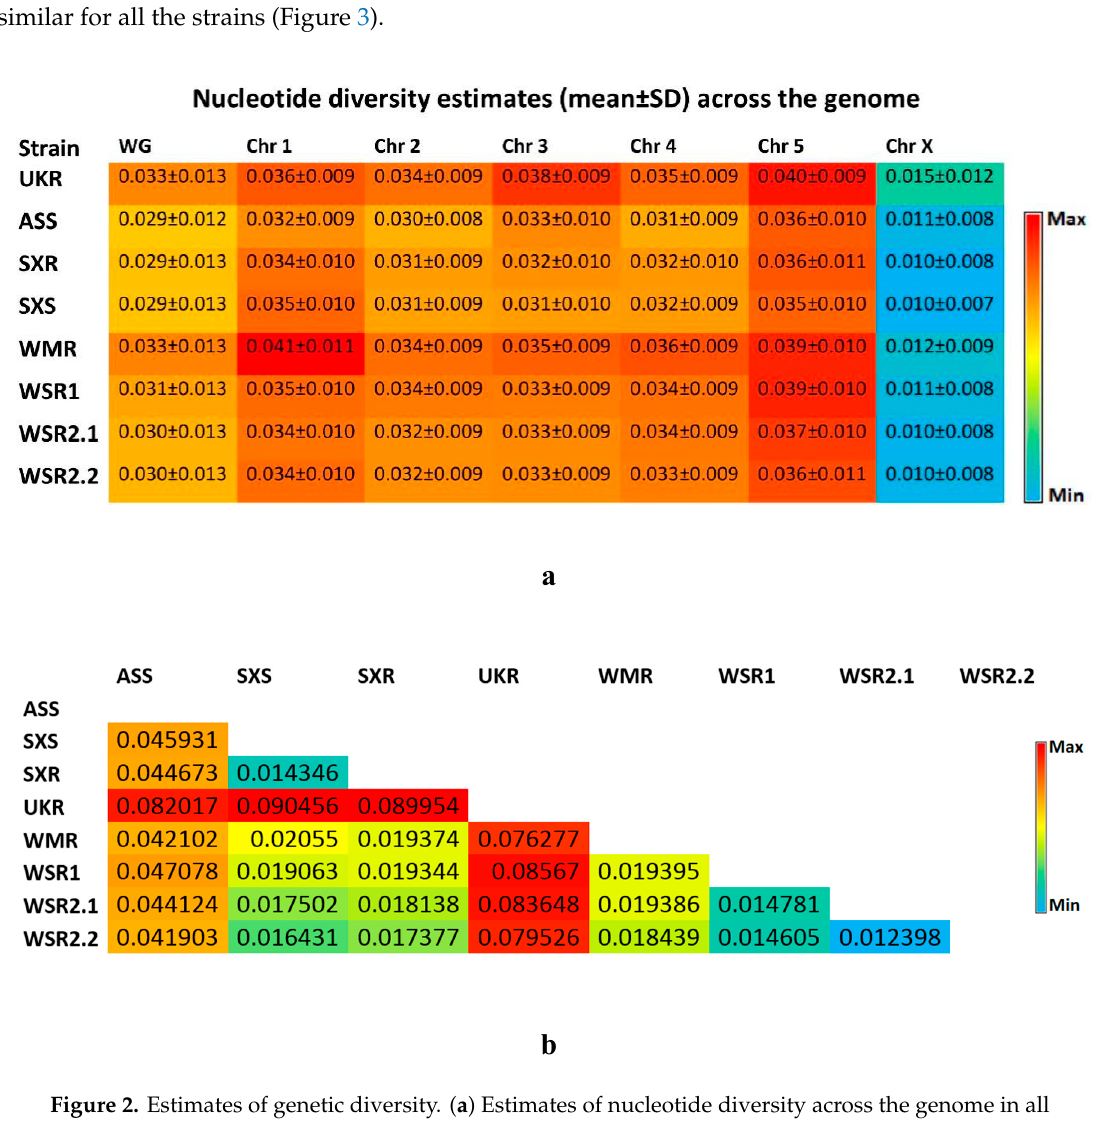
Figure 2. Estimates of genetic diversity. ( a ) Estimates of nucleotide diversity across the genome in all the populations of Haemonchus contortus analyzed in the present study. All values are the mean ± SD. ( b ) Genetic differentiation across the populations of Haemonchus contortus analyzed in the present study. Genome-wide average Fst scores (fixation index) were calculated in pairwise comparisons. Populations’ codes are according to Table 1. Abbreviation: WG, whole genome; Chr, chromosome.